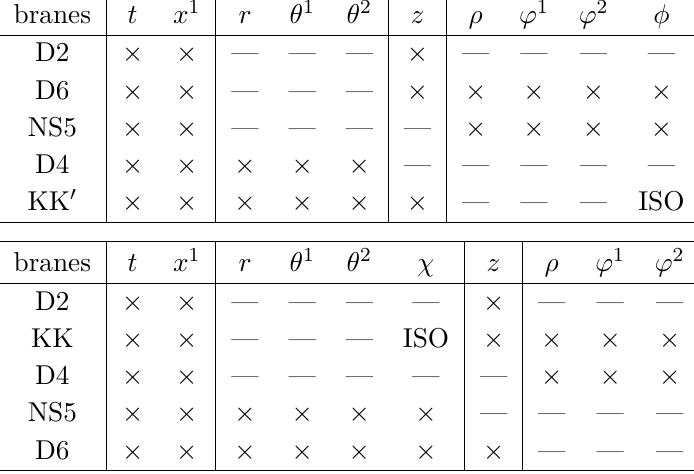
Table 2 . BPS/8 brane intersections underlying the AdS 3 × S 2 × ˜ S 3 / Z k 0 (left-side) and AdS 3 × S 3 / Z k × S 2 (right-side) solutions to Type IIA of [3] and [5]. The intersections are T-duals to D3- NS5-D5 branes ending on NS5 0 -D5 0 background